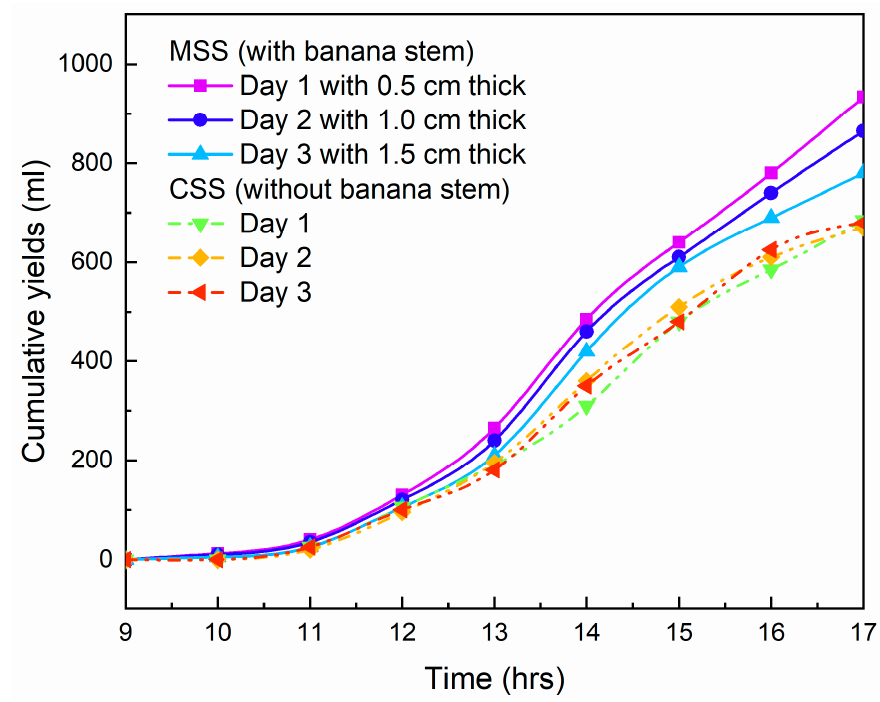
Figure 6. Variation in cthe umulative yield.